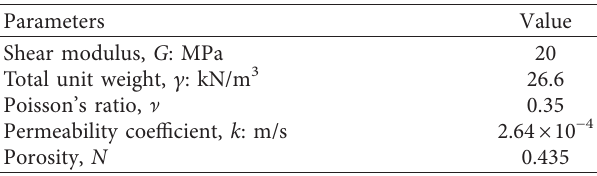
Figure 1: Mesh used in finite difference analysis. Table 1: Summary of soil